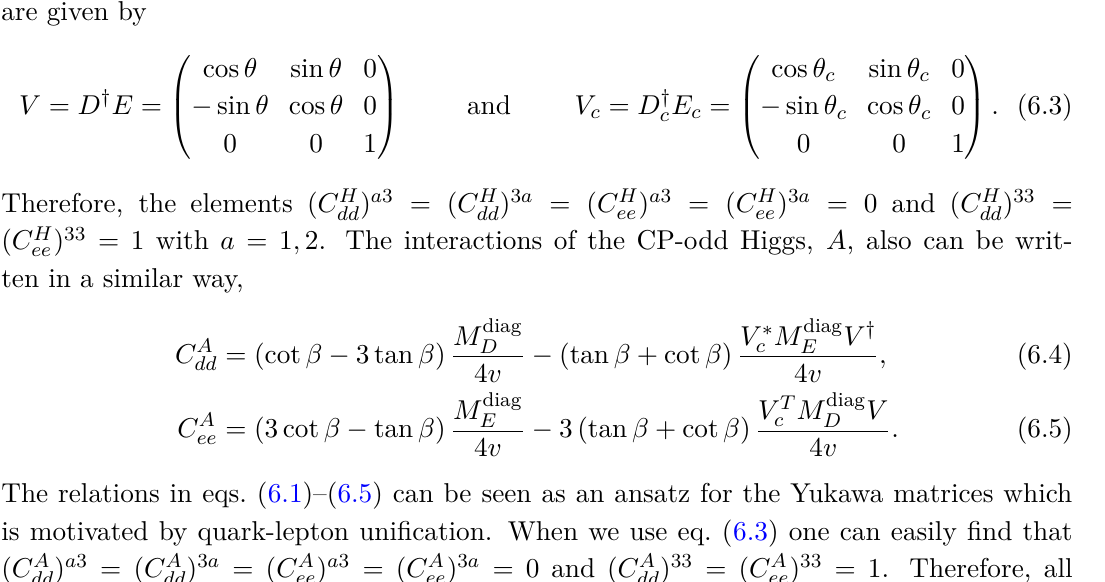
Figure 6 . Experimental constraint from K 0 − results for ∆ m in units of GeV as a function of the mass of the Higgs bosons M K with different colors correspond to different values for tan β as shown in the legend. The region shaded in red gives a larger contribution than the measured value of ∆ m EXP panel we fix the mixing angles to sin θ = sin θ